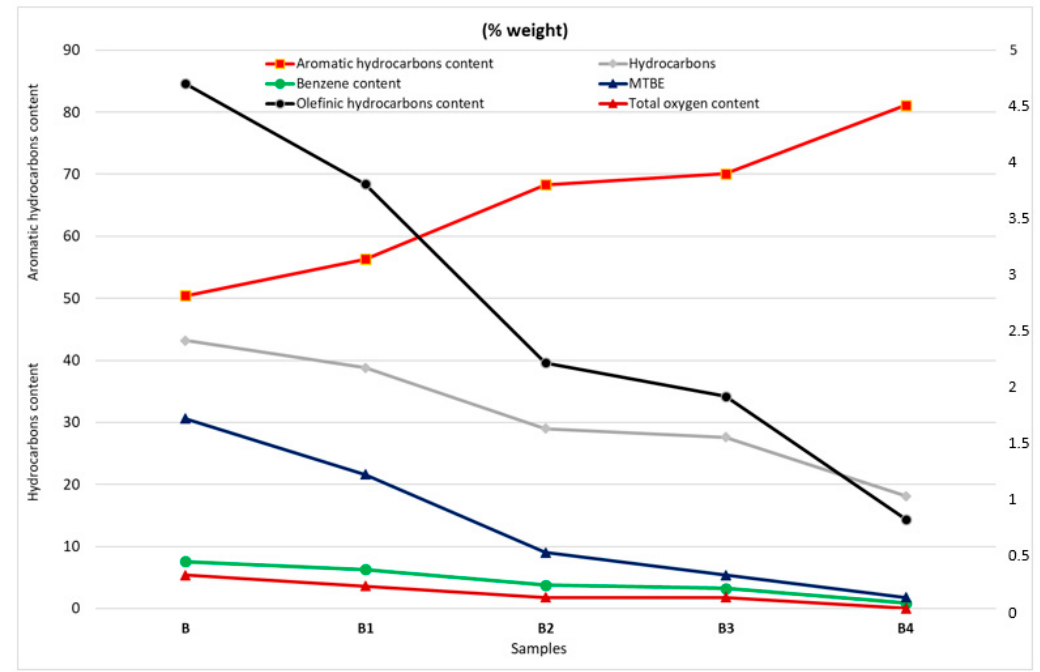
Figure 8. Multidimensional gas chromatography of samples B, B1, B2, B3, and B4.